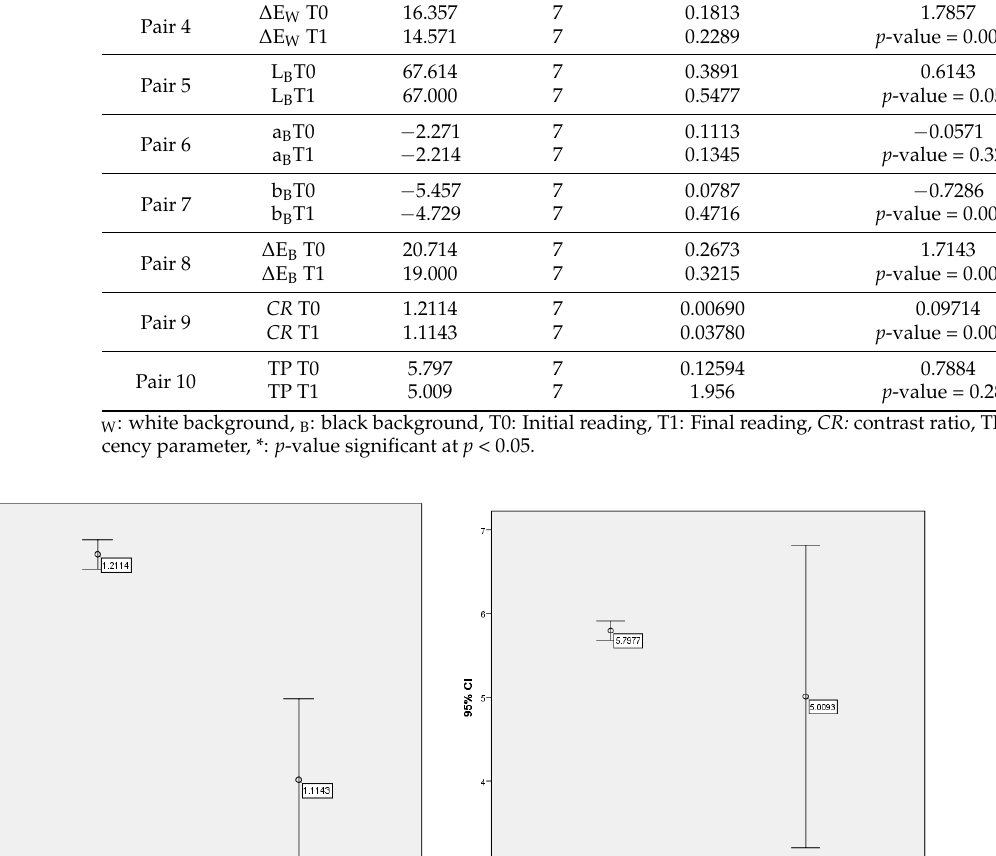
Table 7 shows the Δ E and L coordinates of the L*a*b* system showing statistically Table 7. Paired sample statistics (1500 ◦ significant differences against the white background at 1500 °C, while a* and b* coordi- nates did not show any significant changes. The L*, b*, and Δ E showed significant differ- ences against the black background. There was a significant change observed in the con- trast ratio. No significant change was observed in the translucency parameter. Scheme 4 shows paired comparison at time 0 and time 1 at a temperature of 1500 °C. Table 7. Paired sample statistics (1500 °C).